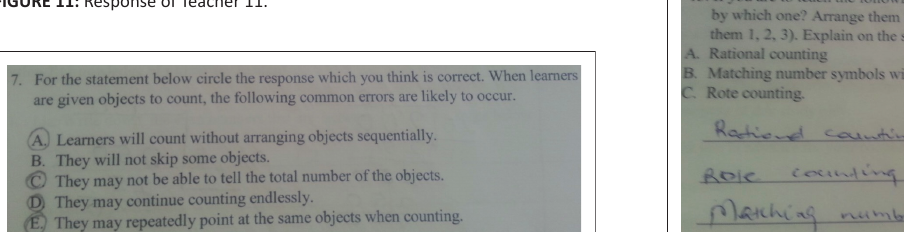
FIGURE 11: Response of Teacher 11.